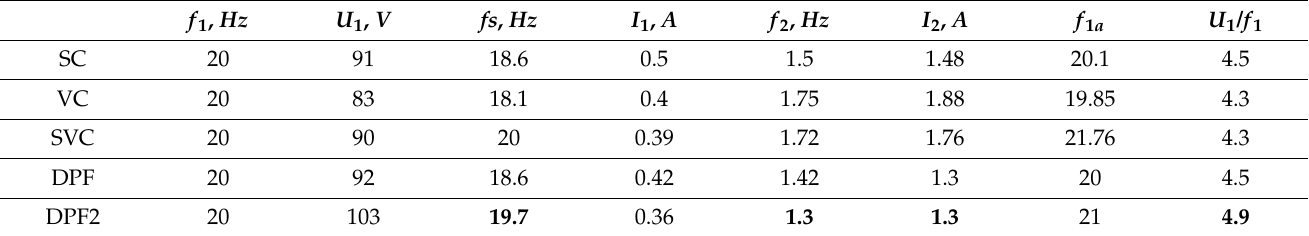
Table 1. At low load, the load drive is switched